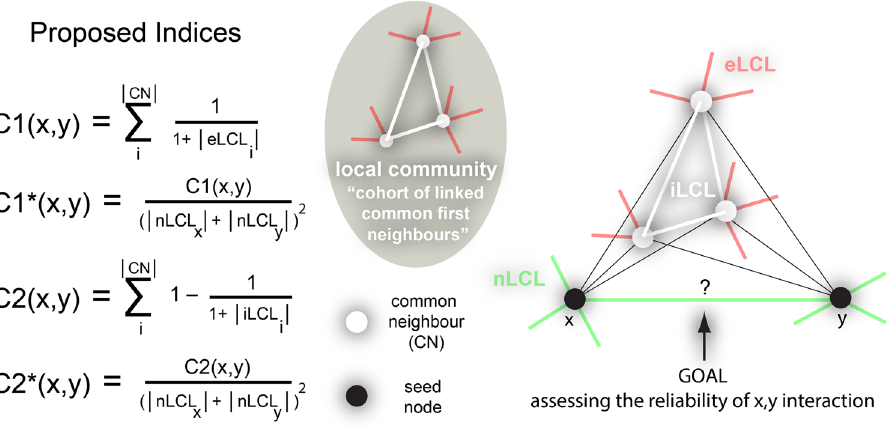
Figure 1. Extended paradigm on local community links. On the left, the mathematical formulae of the four novel local-community-based neighbourhood indices. On the right, an example considering one local community and the proposed subdivision of the seed node’s neighbourhood into: internal local-community- links (iLCL, white lines), external local-community-links (eLCL, red lines) and non local-community-links (nLCL, green